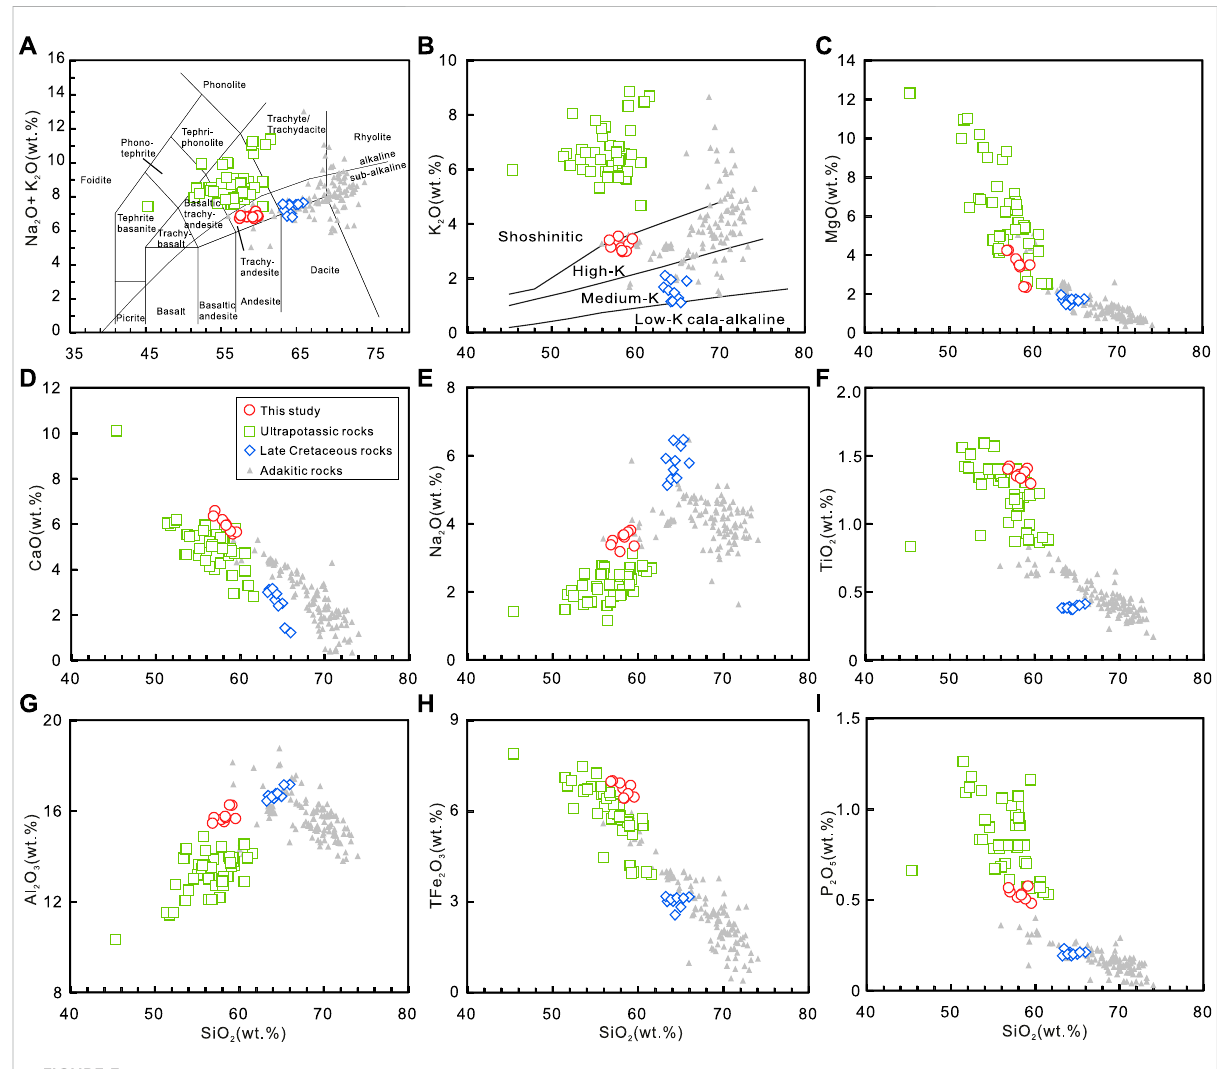
FIGURE 3 Major elemental compositions for Sailipu high-K calc-alkaline trachyandesites. (A) TAS diagram; (B – I) Harker diagrams. Data sources: adakitic rocks (Chung et al., 2003; Hou et al., 2004; Gao et al., 2007; Guo et al., 2007; Xu et al., 2010; Zheng et al., 2012; Ma et al., 2014; Yang et al., 2015; Liu et al., 2017); ultrapotassic rocks (Miller et al., 1999; Zhao et al., 2009; Liu et al., 2014); late Cretaceous magmatic rocks (Sun et al.,